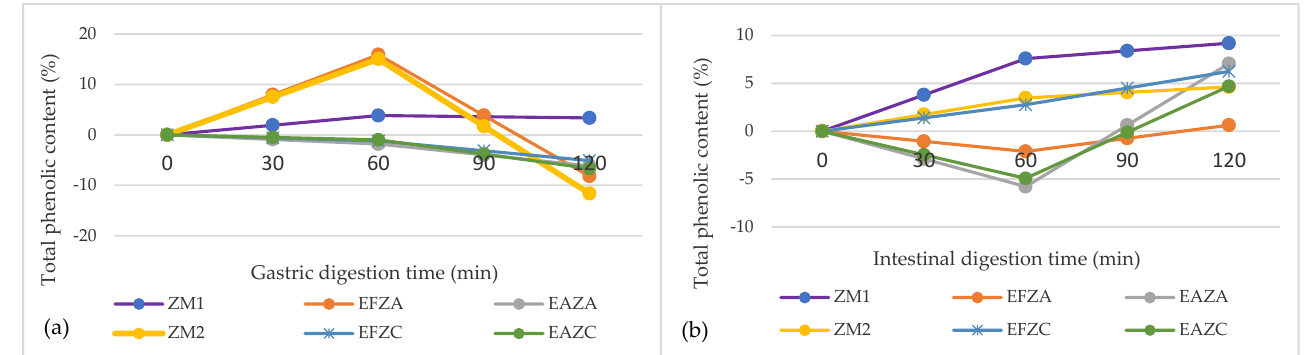
Figure 2. In vitro digestion of the remaining phenolic content in zucchini purees enriched with anise or fennel aqueous extract, in simulated gastric juice ( a ), and simulated intestinal juice ( b ). ZM 1 and ZM 2 are zucchini purees treated by steam convection and hot air convection, respectively; EFZA and EAZA are zucchini purees mixed with fennel or anise aqueous extract, processed by steam convection; EFZC and EAZC are zucchini purees mixed with fennel or anise aqueous extract, treated by hot air